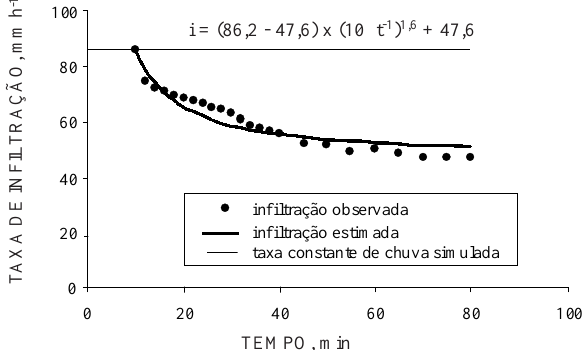
Figura 3. Taxas de infiltração observadas e estimadas para plantio direto sob chuva simulada, com intensidade média constante de 86,2 mm h -1 . Médias de quatro repetições e duas observações por repetição.